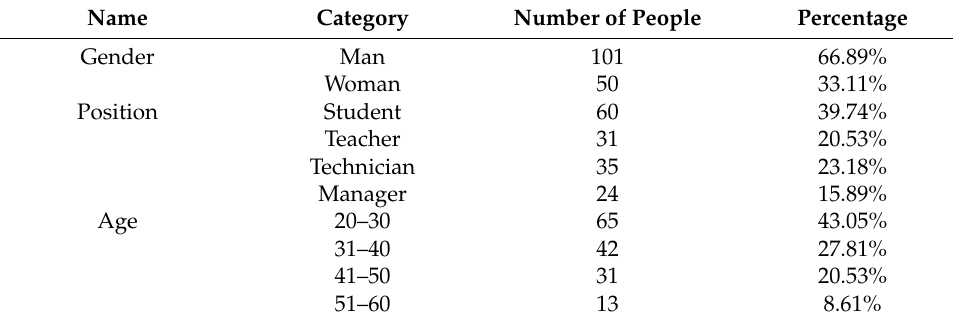
Table 2. Basic information of questionnaire respondents.